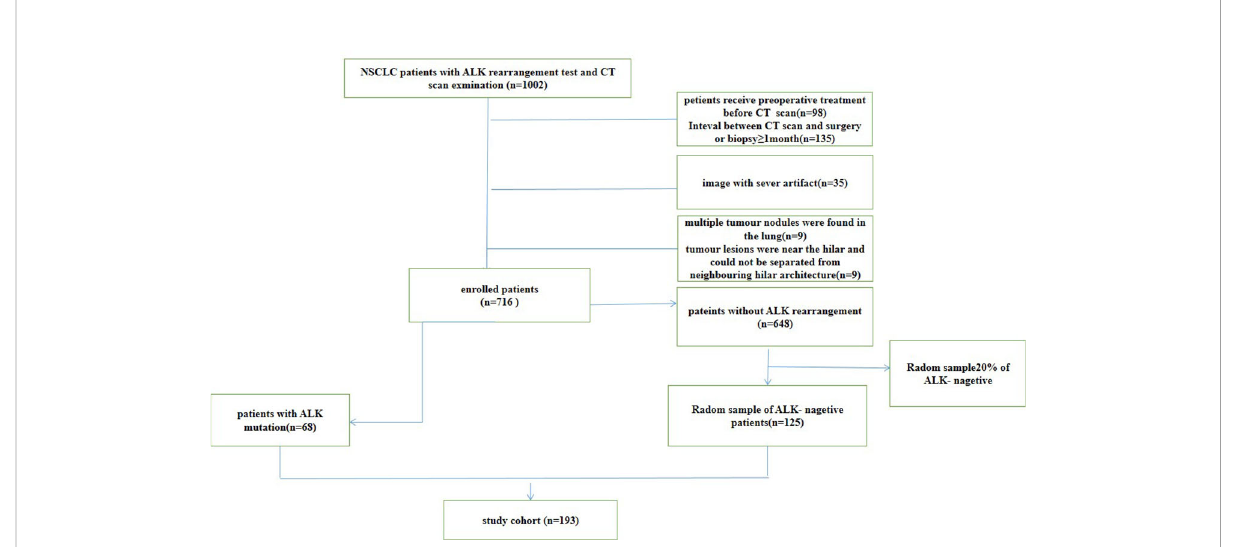
FIGURE 1 The fl owchart of patients selection for non-small cell lung cancer